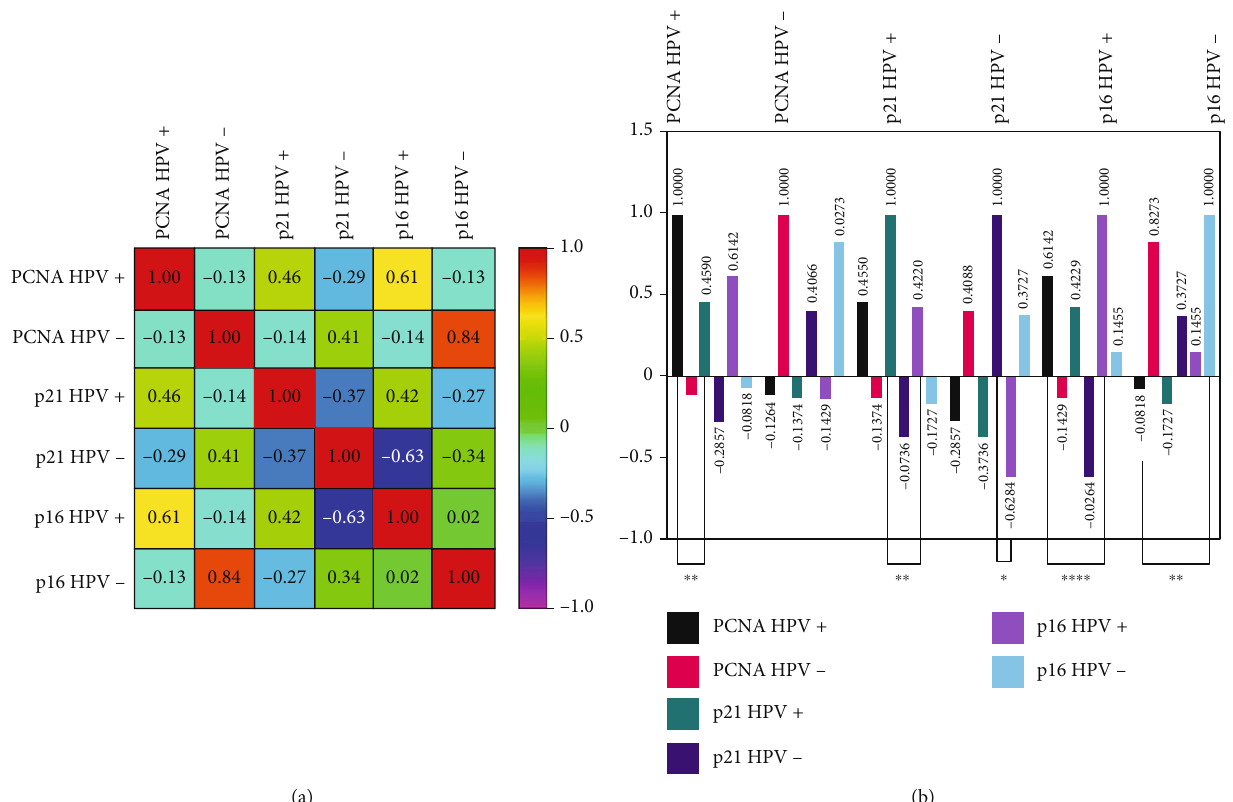
Figure 6: Correlation analysis FFPE+FF samples. (a) Heatmap of Spearman ’ s correlation test between p21, p16, and PCNA in HPV+ and HPV- in FFPE and FF samples. r coe ffi cient is placed inside the cells with a variation from 1 (strongest positive correlation) to -1 (strongest negative correlation). (b) Correlation between p16, p21, and PCNA in HPV+ and HPV- in FFPE and FF samples. Each gene section shows the positive ( r = 1 ) or negative ( r = − 1 ) correlation coe ffi cient in the bar notation of the analyzed target. p value: ∗ < 0.05; ∗∗ < 0.01; ∗∗∗ < 0.001; ∗∗∗∗ <